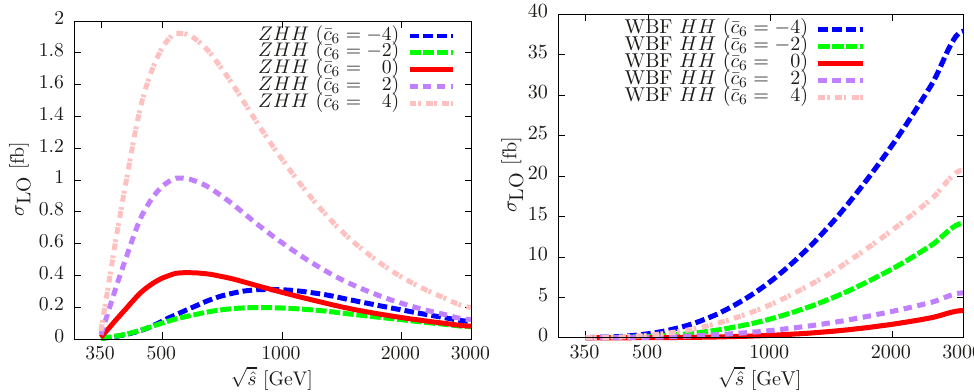
p ^ s for di(cid:11)erent values of (cid:22) c 6 .